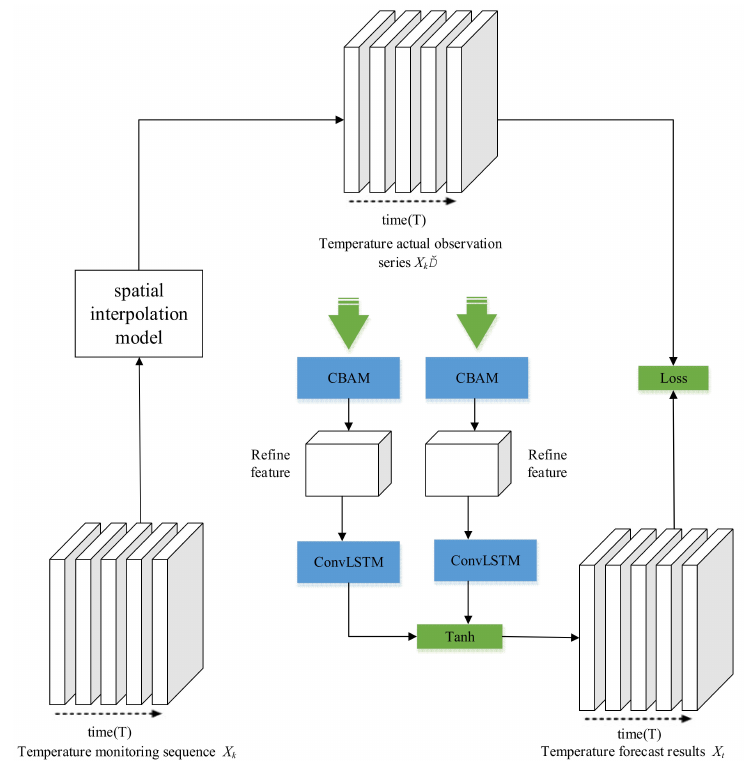
Figure 6. Structure of the ST-Net